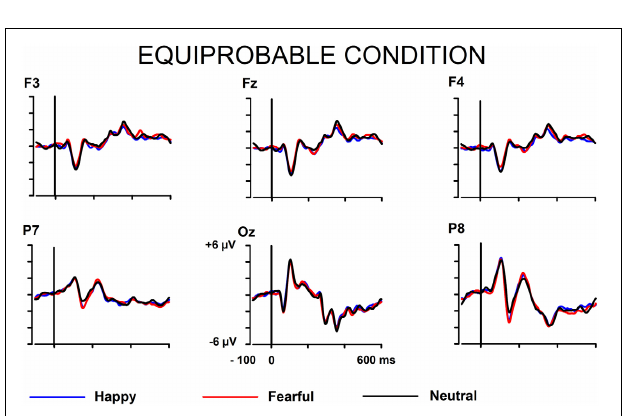
FIGURE 2 | Grand-averaged ERPs in the equiprobable condition. Raw ERPs to happy, fearful, and neutral faces. Stimulus onset at time 0.